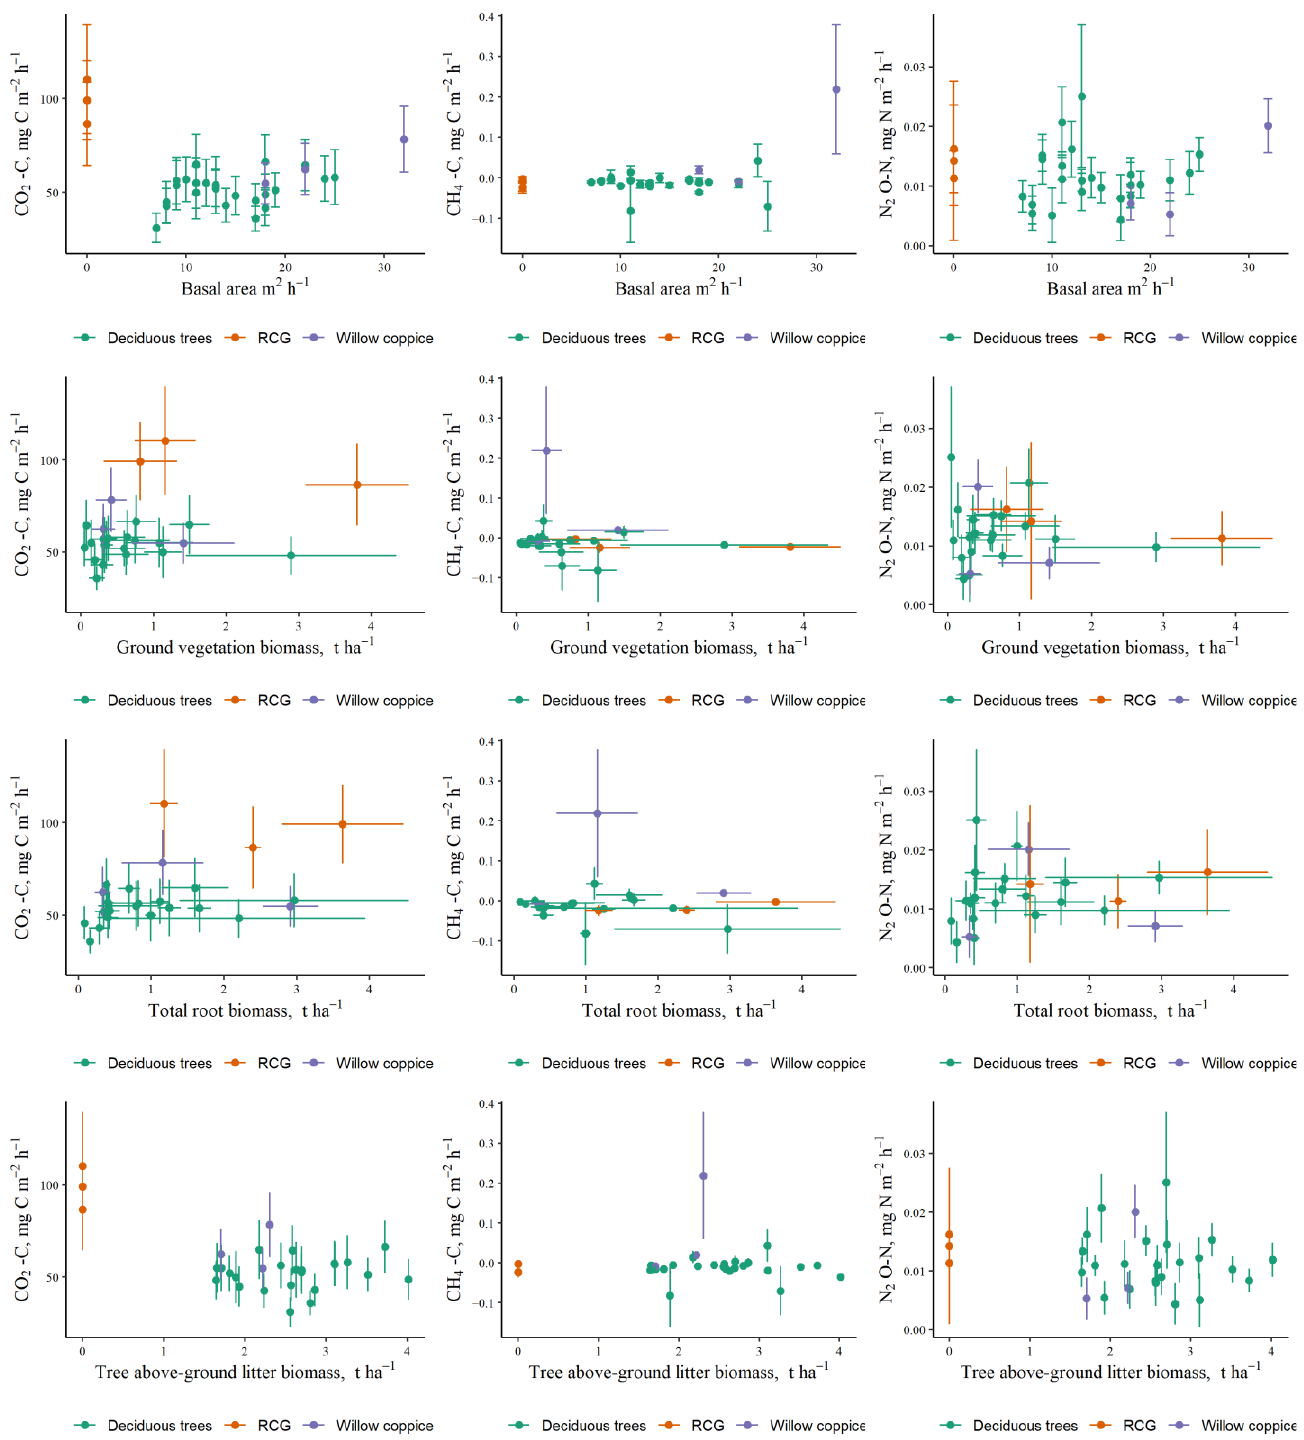
Figure 5. Relationships between mean soil GHG fluxes and parameters of vegetation biomass in plots dominated by deciduous trees, willow coppice, or RCG in agroforestry systems in hemiboreal